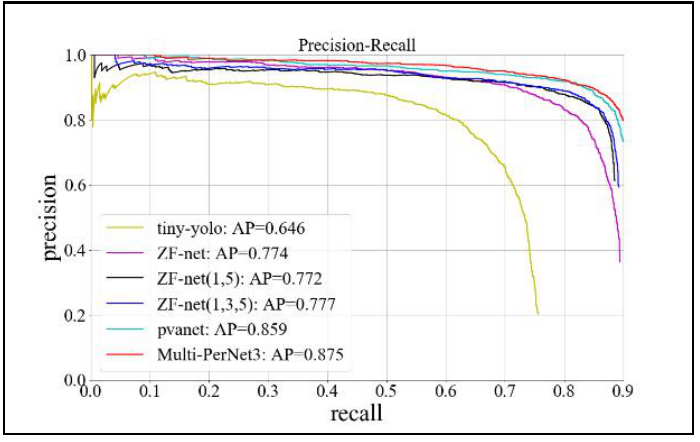
Figure 14. P-R curve. ISPRS Int. J. Geo-Inf. 2018 , 7 , x FOR PEER REVIEW 11 of 15